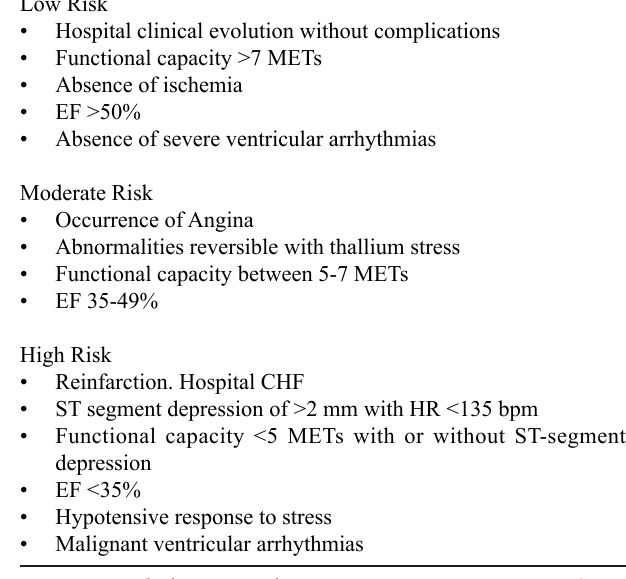
Chart 7. SFC criteria for risk stratification of events during the year. Low Risk